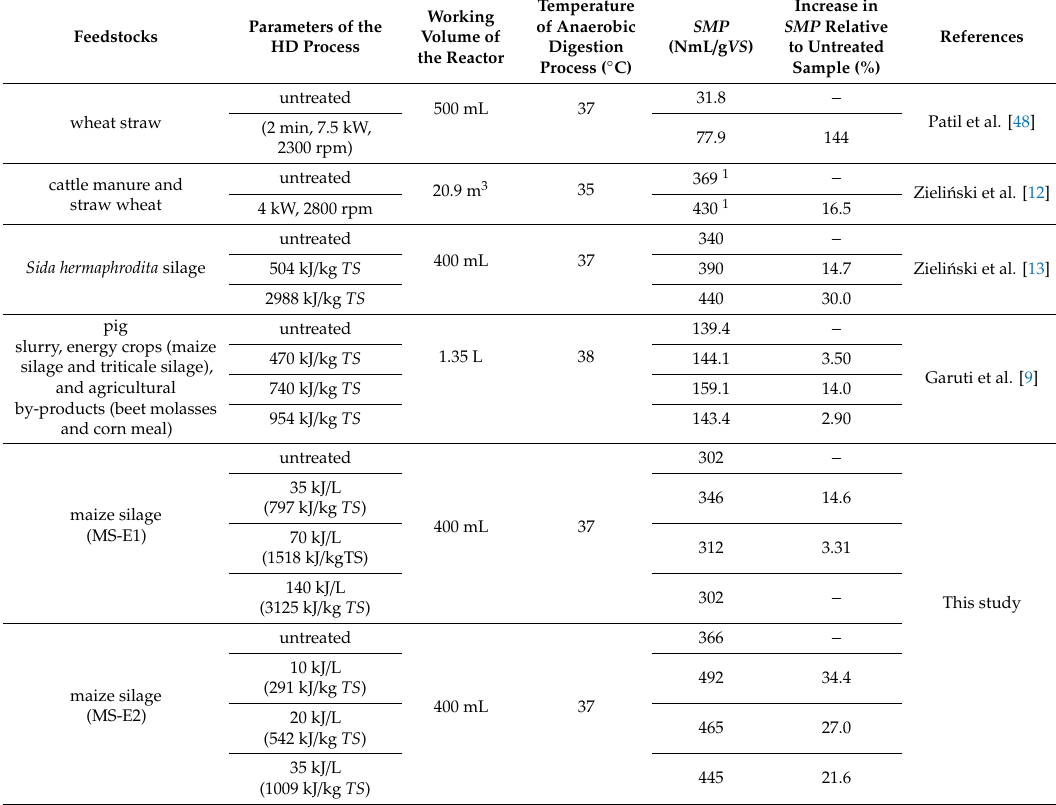
Table 3. E ff ect of hydrodynamic disintegration on specific methane production of feedstocks used in an agriculture biogas plant—literature review and results obtained in this